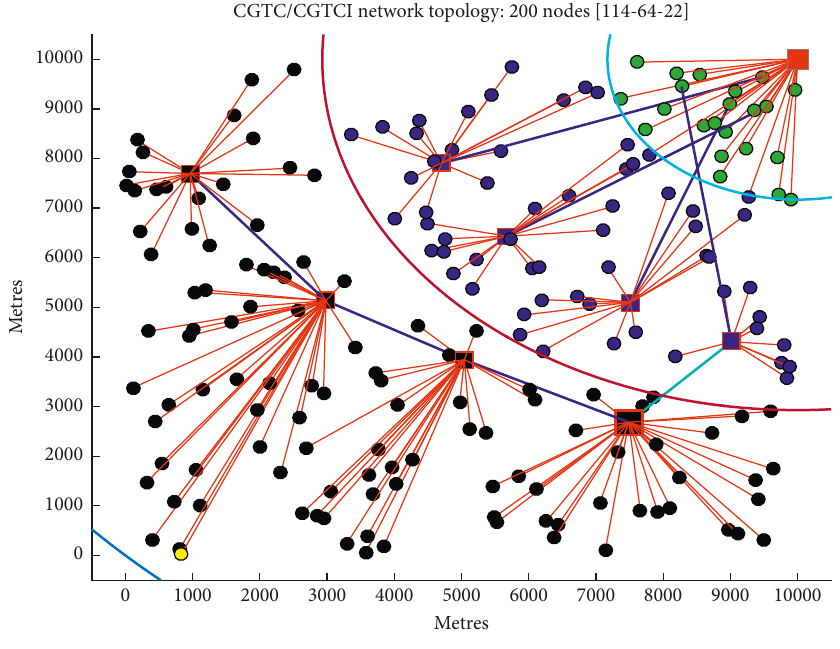
Figure 6: CGTC/CGTCI simulation scenario.